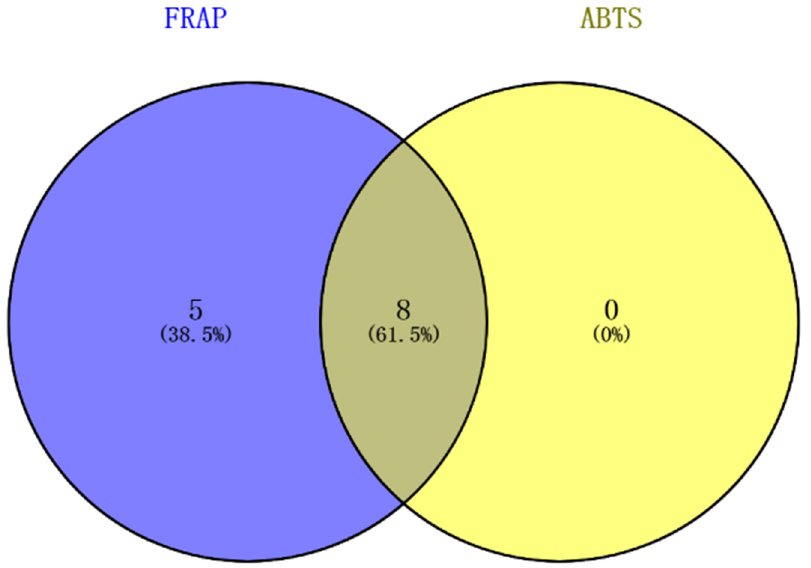
Figure 8. The Venn diagram of two assays.